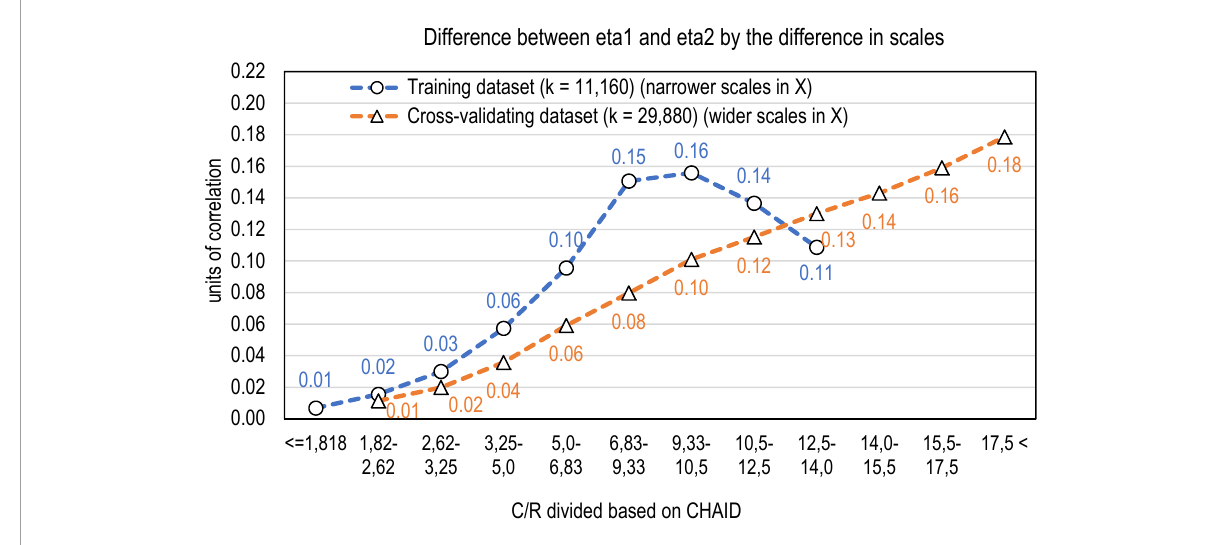
FIGURE3 Discrepancy between the scales of the variables explaining the difference in eta1 and eta2 ( k = 11,160 + 29,887